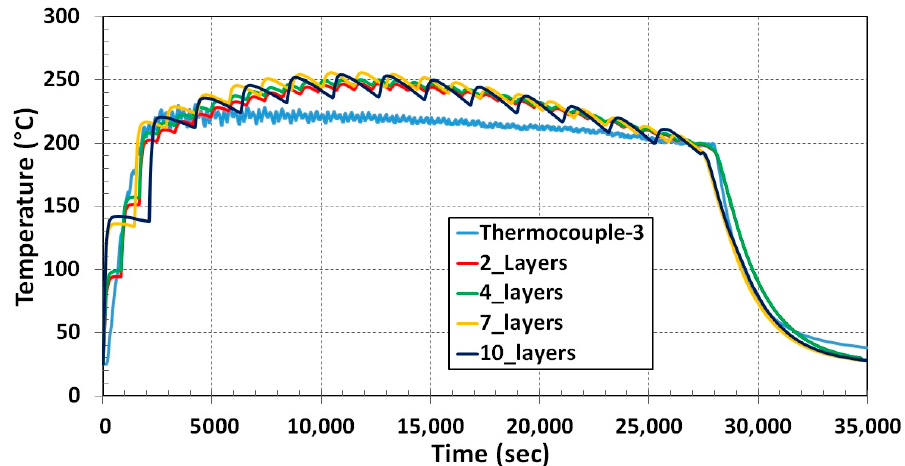
Figure 21. Temperature comparison for all four cases of lumping layer with the experiment result.